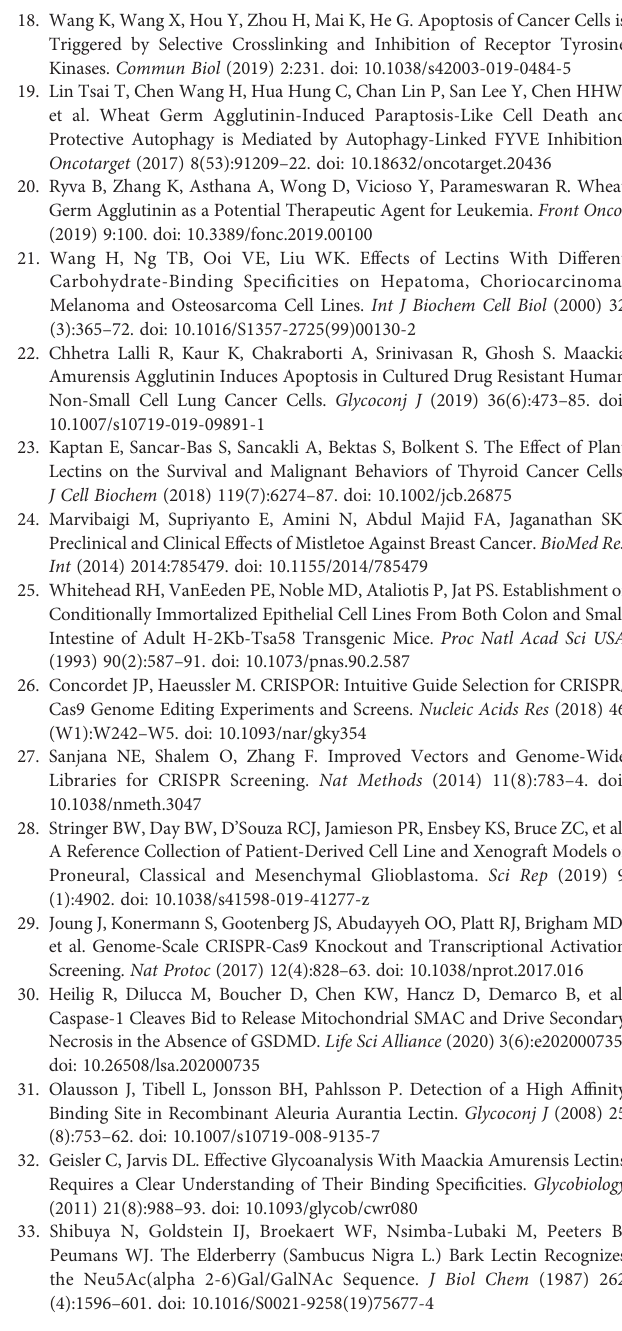
positive controls cisplatin and TNF. (B) Validation of caspase 9 cleavage in MC-38 treated with cisplatin, equivalent volume of deionized water and mouse embryonic fi broblasts (MEF) untreated and treated with cytochrome C. Supplementary Figure 4 | Binding of plant lectins to non-transformed YAMC cells using same fl ow cytometer settings as for MC-38. (A) Binding ability of lectins used inthe studyto YAMCcellsmeasured by fl owcytometry. UnstainedYAMC (red lines), stained YAMC (green lines). (B) Comparison of lectin mean fl uorescence intensities in MC-38 and YAMC. Each lectin was used at 10 m g/ml. Data are presented as mean and standard deviation of three